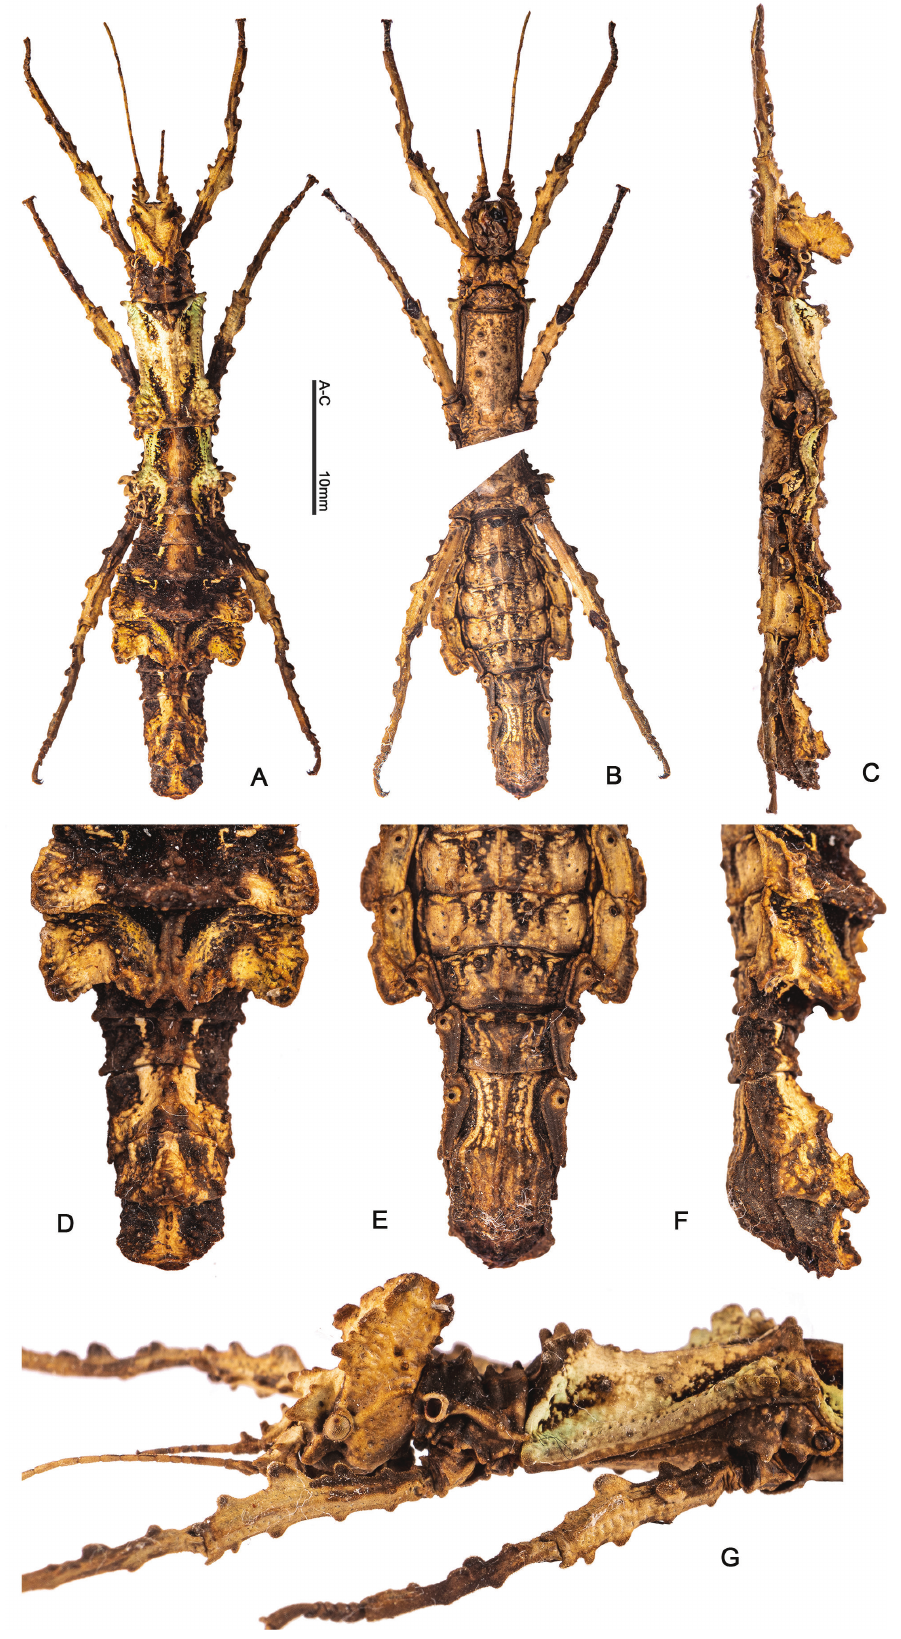
Fig. 1. Female (HT) of Pylaemenes gulinqingensis sp. nov. Habitus A. Dorsal; B. Lateral; C. Ventral, end of the abdomen; D. Dorsal; E. Lateral; F. Ventral, head and thorax G.